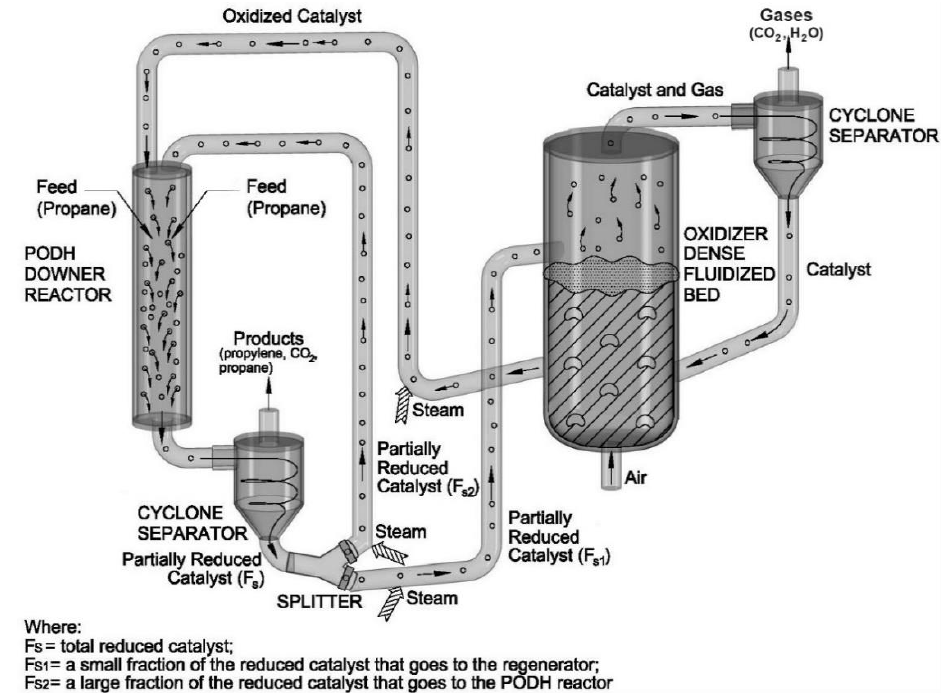
Figure 8. Schematic Oxidative Dehydrogenation (ODH) Process Flow Sheet Displaying the Anticipated Industrial Operation for a PODH Process. Adapted with permission from [59], copyright 2017, American Chemical Society.